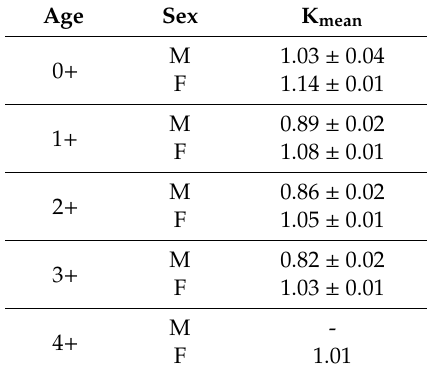
Table 5. Age class, sex, and relative K mean (mean ± standard deviation) for S. fontinalis